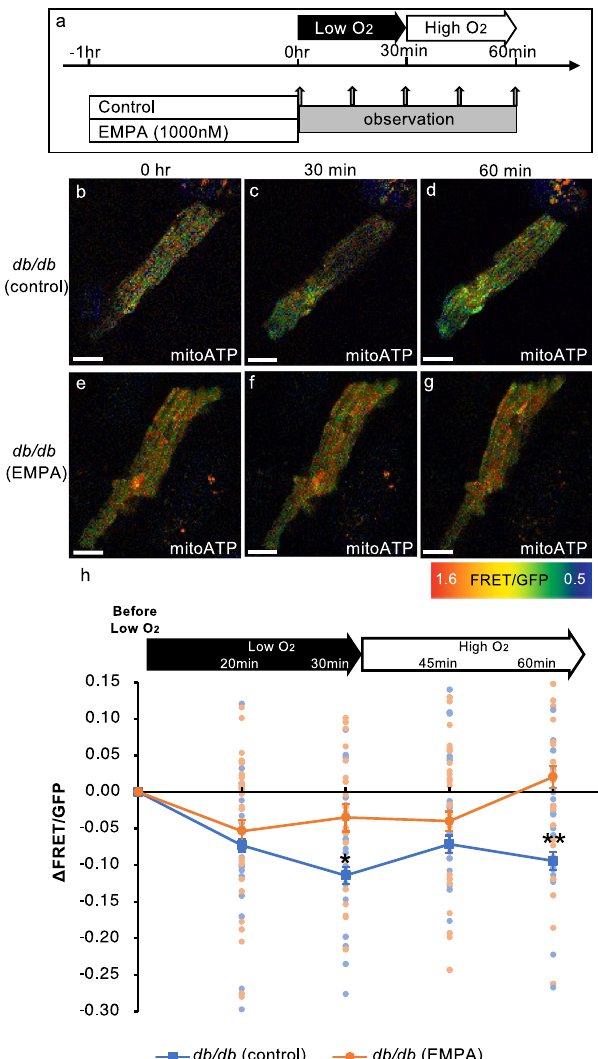
(Fig. 6d, p = 0.046). In empagli fl ozin-treated cardiomyocytes, the FRET/GFP ratio was signi fi cantly increased to 1.42 ± 0.006 (Fig. 6d, p = 0.0012). To investigate the effect of cariporide and